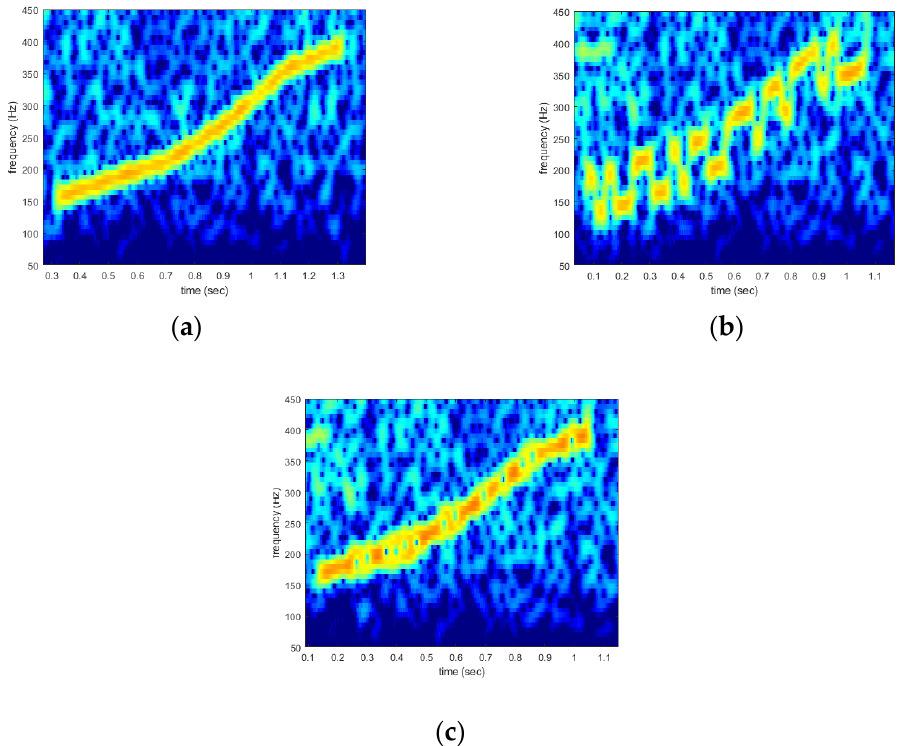
Figure 8. Mimicking whistles for the DoM evaluation: ( a ) the proposed method, ( b ) FSK, and ( c ) CVC-FM and TFSK. Table 1. The result of the DoM evaluation.